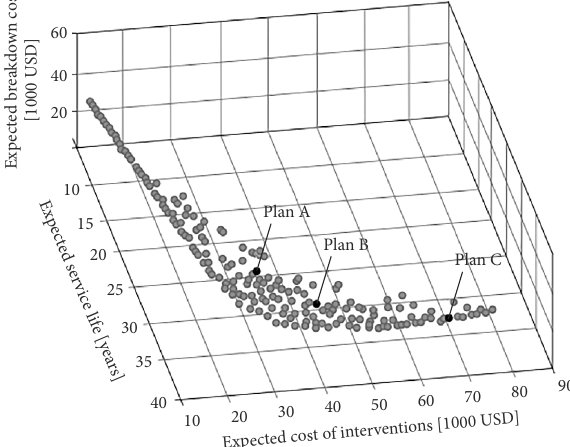
Figure 3. Pareto solution set with objectives to minimize expected total inspection cost and expected breakdown cost and maximise expected inspection interval Table 3. Three optimal inspection plans of multi-objective optimization problem Design variables Plan